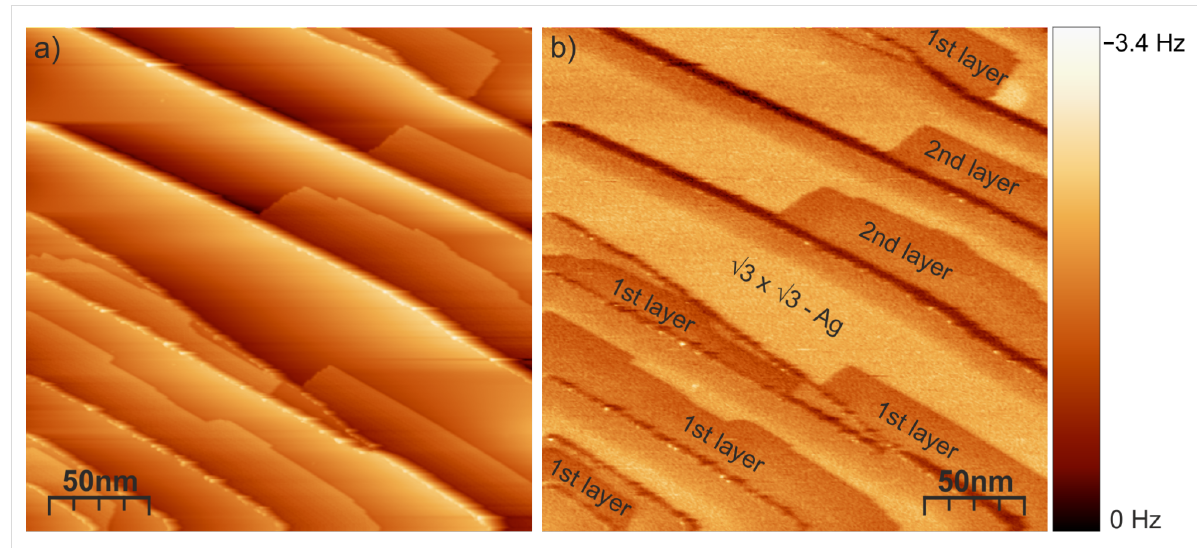
Figure 1: (a) STM image of the PTCDA/Ag/Si(111) √ 3 × √ 3 surface. Scan area: 250 nm × 250 nm, tunneling voltage U = 0.9 V, tunneling current I = 70 pA. (b) Simultaneously recorded frequency shift at an oscillation amplitude of 2.8 Å. The Ag/Si(111) √ 3 × √ 3 surface gives rise to a larger frequency shift than the PTCDA